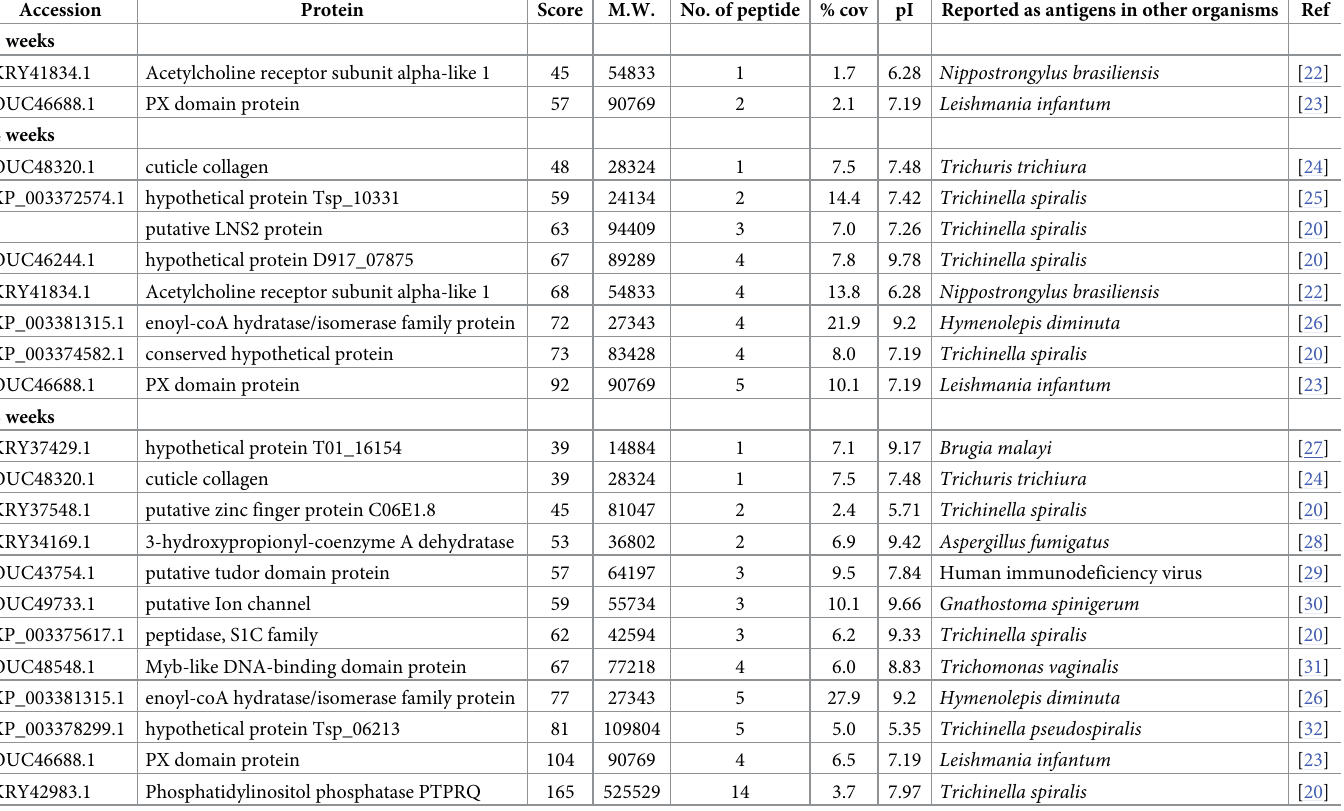
Table 3. Identification of T . spiralis proteins from infected mouse immune complex at 2, 4 and 8 weeks after T . spiralis infection. The immune complexes in T . spira- lis uninfected and infected mouse serum were enriched using protein A/G magnetic bead. The T . spiralis proteins from infected mouse immune complex were identified using LC-MS/MS and the NCBI database was used with T . spiralis set as the taxonomy filter. Score